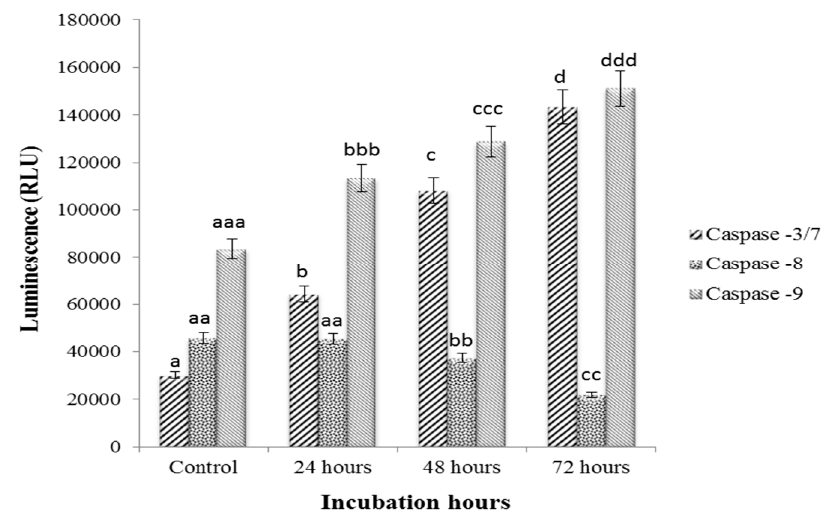
Figure 4. Relative luminescence expression of caspase-3/7, -8 and -9 in HepG2 cells treated with sulforaphene (33.8 µ M) for 24, 48 and 72 h. Cells were cultured in serum free RPMI-1640 medium and maintained at 37 °C and 5% CO 2 . Values are presented as means ± SD of triplicate experiments, and means with different letters differ significantly ( p < 0.05).